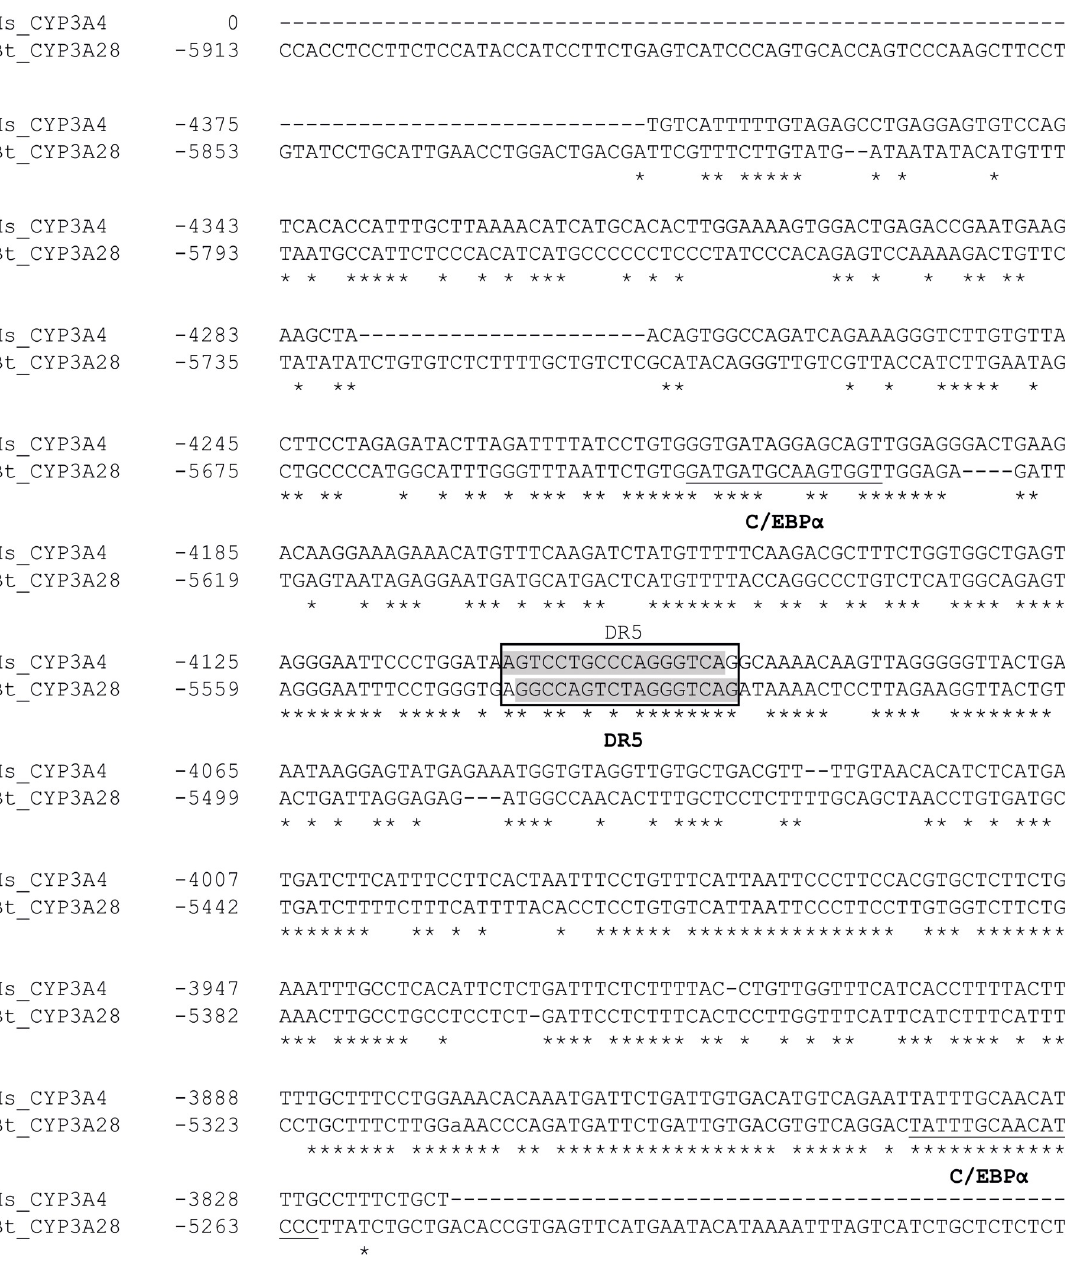
Fig 2. Sequence comparison and distribution of distal regulatory elements in the bovine CYP3A28 F3 fragment and human CYP3A4 promoter region. Identical nucleotides are denoted by asterisks. The sequence is numbered relative to the transcription start site taken as +1. The newly identified bovine elements (C/EBP α ) are bolded and underlined. The DR5 element, identified in both species through NUBIscan analysis, is highlighted in grey colour and